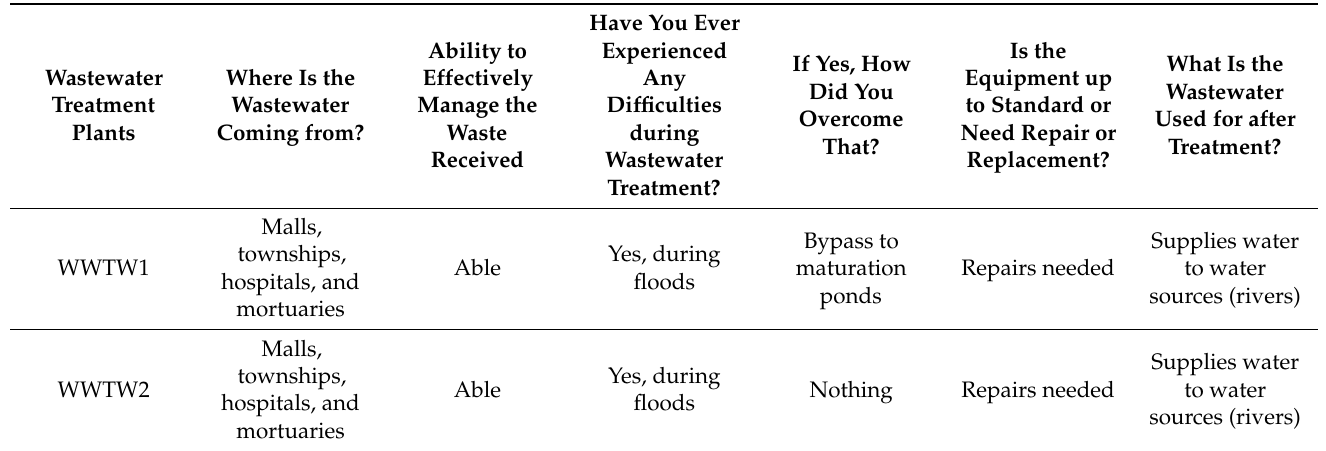
Table 4. Wastewater treatment plant